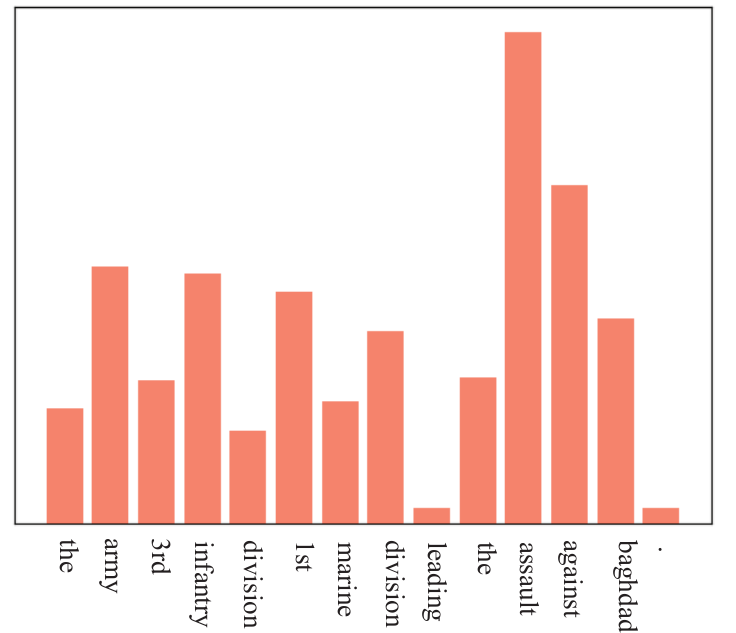
Figure 6. The attention scores for the hidden embeddings of words, which our model learns from a sample